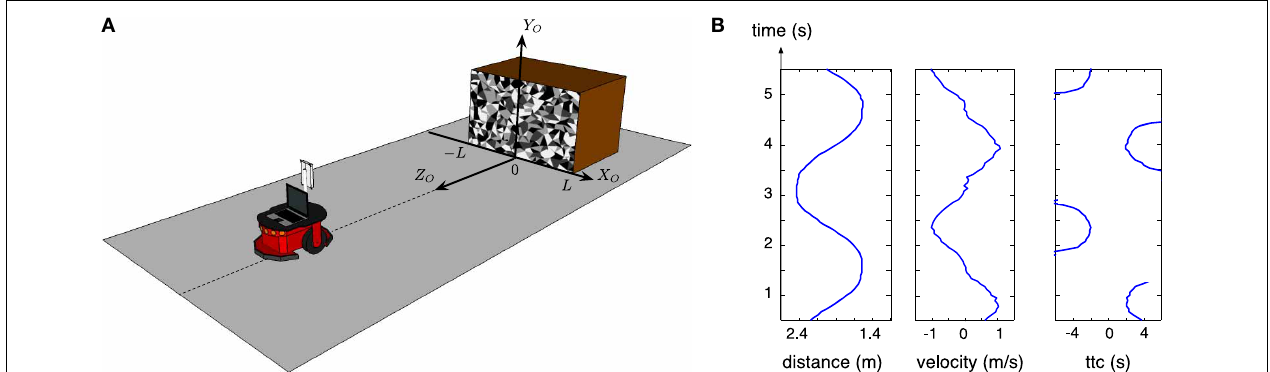
TTC over time are computed based on the odometer of the robot. Only the TTC computed while the velocity of the robot is superior to 0 . 1m/s is given, because it tends to infinity when velocity tends to 0.